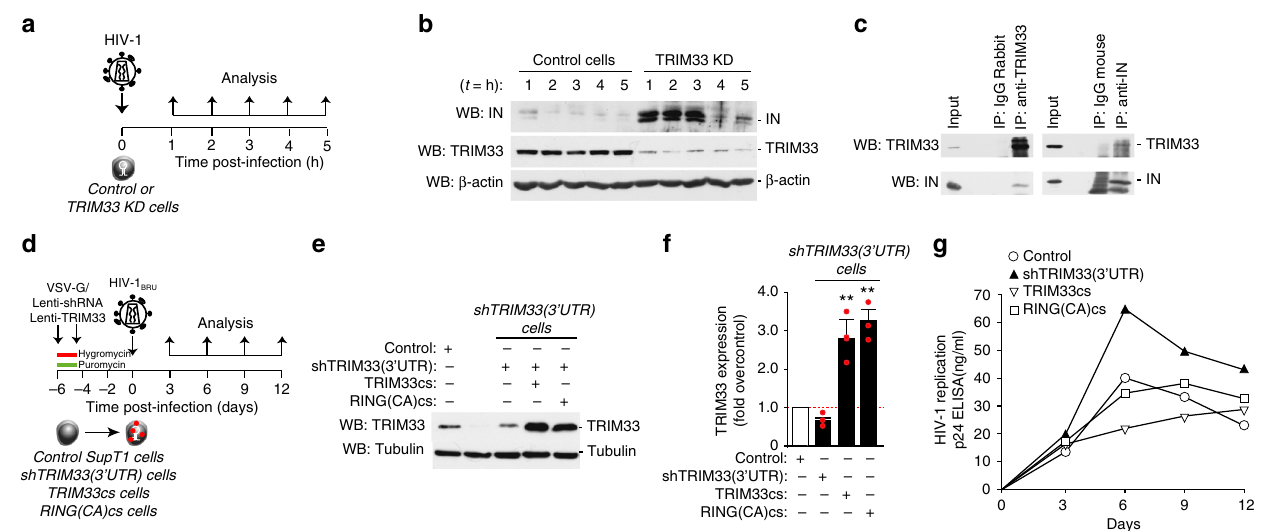
Fig. 7 Interaction of TRIM33 with integrase from infectious HIV-1. a Analysis of IN protein levels in TRIM33-knockdown (TRIM33 KD) cells during HIV-1 infection. Cells stably expressing an anti-TRIM33 shRNA were infected for 1 h with HIV-1; at the indicated time points after infection, cells were washed with PBS and the levels of IN were analyzed. b Western blot showing IN levels in control and TRIM33 depleted cells Beta-actin was used as a loading control; TRIM33 downregulation was veri fi ed using an anti-TRIM33 antibody. c TRIM33 interacts with IN during HIV-1 infection. SupT1 cells were infected with HIV-1 in the presence of MG132. Either TRIM33 or IN were immunoprecipitated with the respective antibodies, followed by immunoblotting to test the presence of the reciprocal protein. d Analysis of the effect of stable knockdown and overexpression of TRIM33 variants in multiple round infection with wild-type HIV-1. SupT1 cells stably expressing an hRNA targeting the TRIM33 3 ′ -UTR (selected after transduction with a lentiviral vector and selection for puromycin) were transduced with lentiviral vectors expressing the TRIM33 coding sequence (cs) or the coding sequence of the RING(CA) mutant. After selection with hygromycin, cells were infected with wild type HIV-1 BRU, followed by analysis of infection over time by p24 ELISA. e Western blotting analysis showing TRIM33 levels after transduction with shRNA targeting 3 ′ -UTR of TRIM33 alone or after transduction of wild-type or mutant TRIM33 (TRIMM33cs or RING(CA)cs. Tubulin was used as a loading control. f real-Time RT-PCR analysis showing TRIM33 expression after transduction with the shRNA targeting the 3 ′ -UTR of TRIM33 alone or after transduction of wild type or mutant TRIM33. g Stable knockdown of TRIM33 enhances wild-type HIV-1 replication, while overexpression of its catalytically active cDNA reduces it. The graph shows the levels of p24 in control Sup1 cells or cells previously transduced with anti-TRIM33 shRNA targeting the 3 ′ -UTR of the protein, with or without transduction with a lentiviral vector expressing the